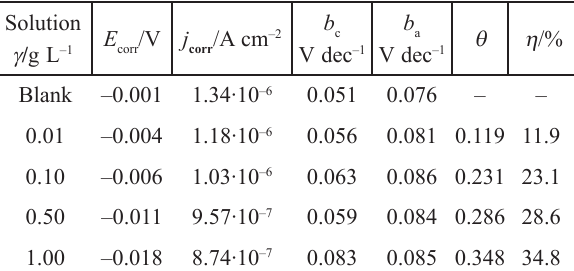
Table 2 – Electrochemical parameters (polarization mea­ surements) and calculated values of surface coverage, q , and inhibition efficiency, h , obtained from data shown in Fig.